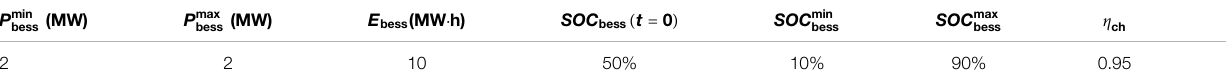
TABLE 2 | Main parameters of